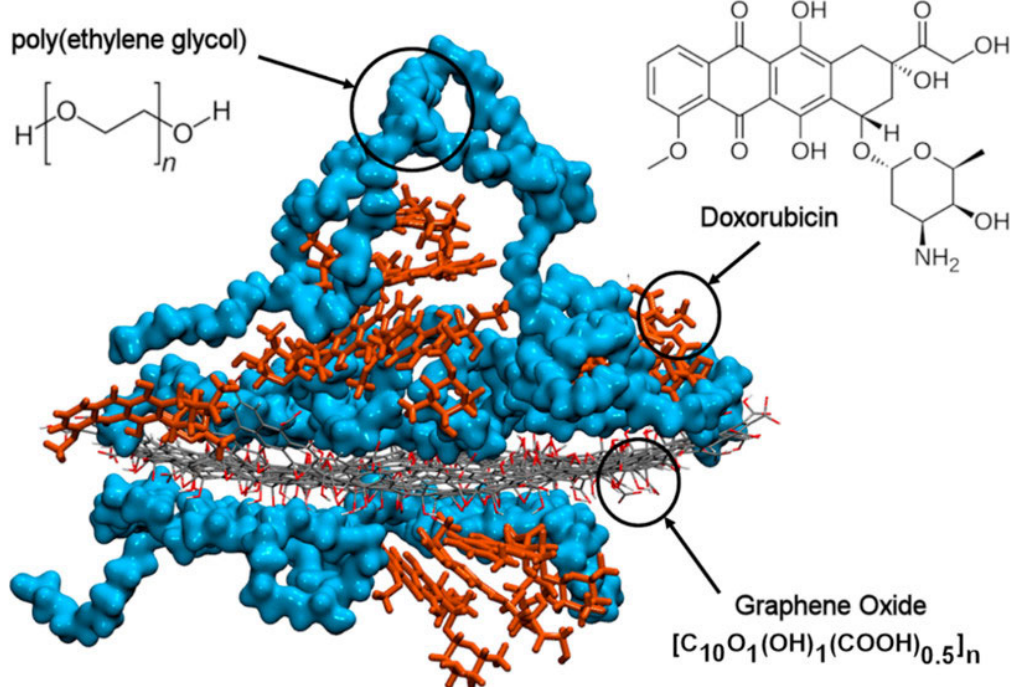
Figure 3. Molecular dynamics (MD) simulations of PEG-decorated GO (PEG-GO) nanocarriers